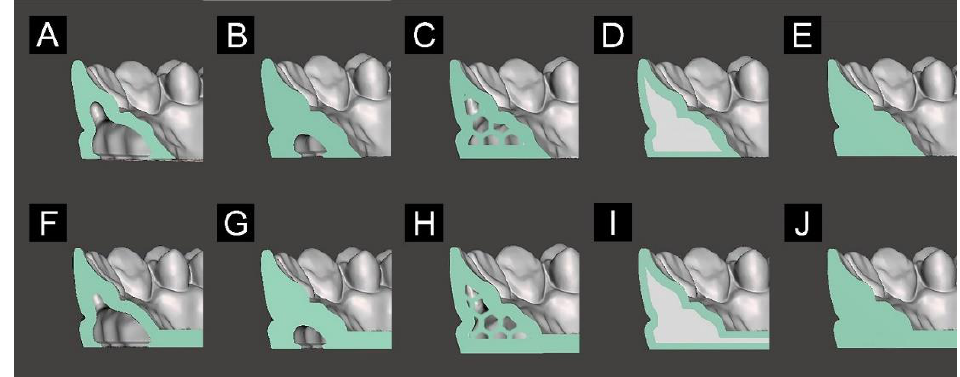
Figure 3. Designs of the 3D printed models: ( A , F ) hollow model with a 1.5 mm-thick shell, ( B , G ) hollow model with a 4 mm-thick shell, ( C , H ) hexagon-filled model, ( D , I ) roughly filled model, ( E , J ) fully filled